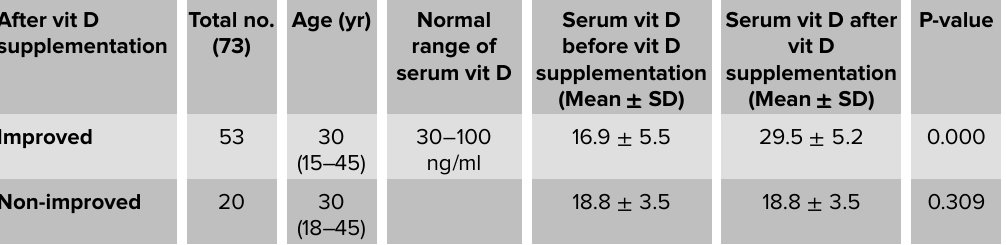
TABLE 1: The relationship between the serum level of vit D in improved and non-improved group.